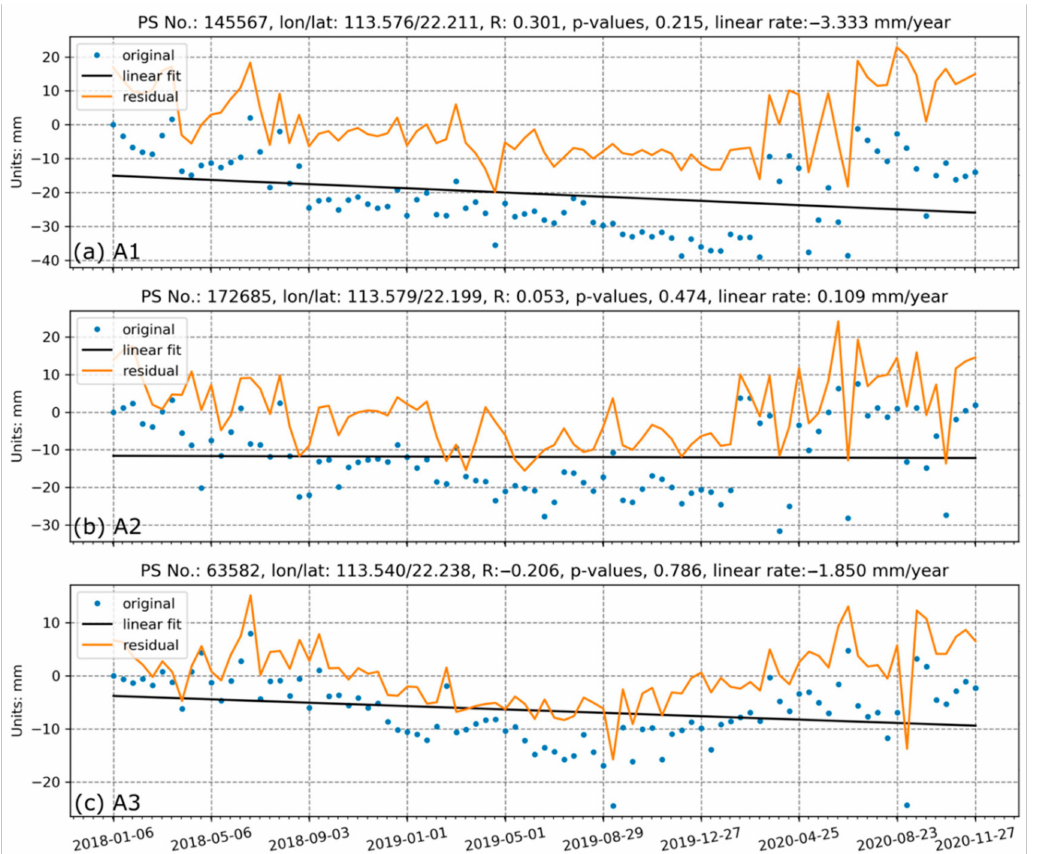
Figure 16. The displacement variation of ( a ) A1, ( b ) A2 and ( c ) A3 in Figure